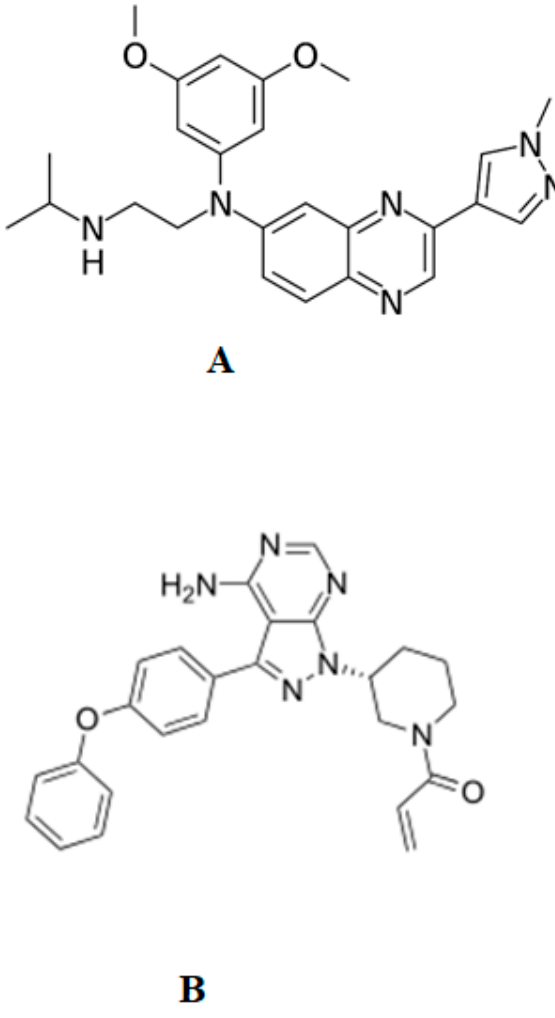
Figure 1. Chemical structure of Erdafitinib ( A ) and Ibrutinib ( B ).